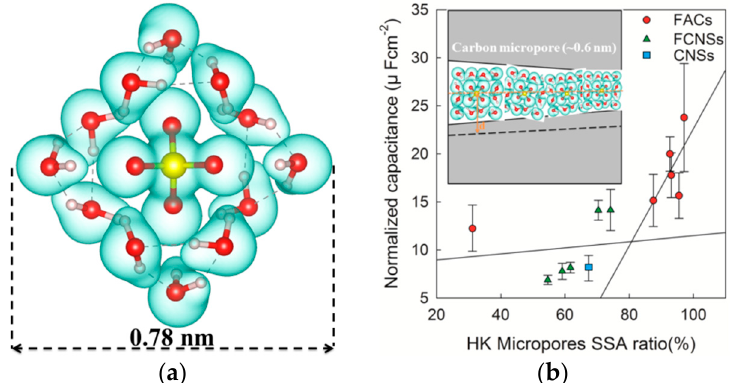
Figure 2. ( a ) Solvated configurations of the SO 42 − · (H 2 O) 12 cluster. Oxygen, hydrogen, and sulfur are represented in red, purple, and yellow, respectively. The dotted lines indicate hydrogen bonds. ( b ) Plot of specific capacitance normalized by BET specific surface areas (SSA) for the carbons in this study (FACs and CNSs) and in the other study (FCNSs) with identical electrolytes. The normalized capacitance increased with increasing of HK micropores SSA ratio with two-stage linear simulation. ( b insert) Drawings of solvated ions residing in pores with distance between adjacent pore walls of ~0.6 nm illustrate this behavior schematically.